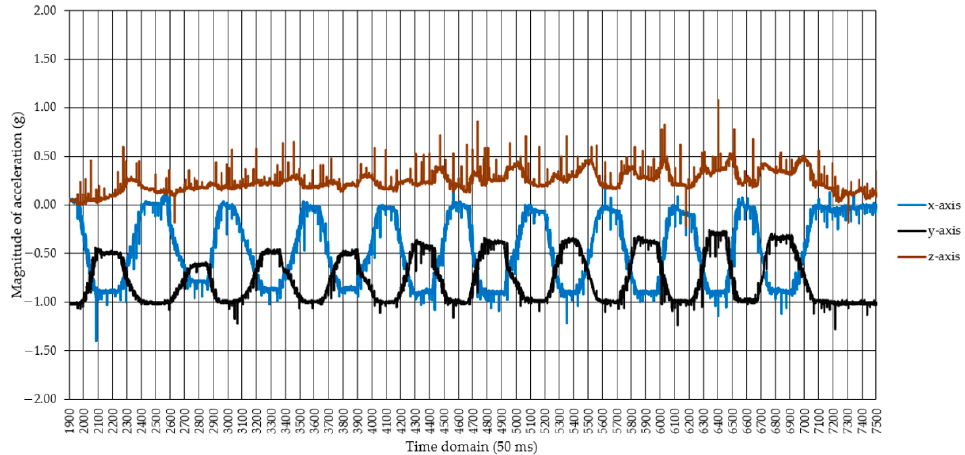
Figure 2. An example of the raw data collected by the triaxial accelerometer for the subprotocol A1, involving back bending to the left of the subject: the x, y, and z axes in the legend stand for the responses (g) on x, y, and z axes, respectively; right end part of the figure (from 7050 to 7500 50-ms increments) shows in the responses on the three axes during part of the time in which the orthostatic posture was maintained; relatively static responses in the figure indicate the time in which a given posture was maintained; increments and decrements in magnitude indicate the time in which movements were done to change a given posture. Note: the signal contained impulse noise and oscillations. Table 1. Description of the coding protocol used in this study.